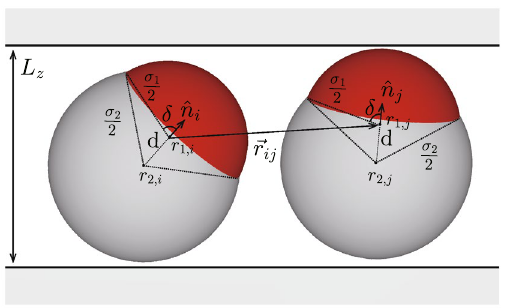
Figure 1. System used in simulations, where dumbbell-like one-patch particles are confined between two flat walls. The particles are synthesized by merging two spheres. Red and white regions represent attractive area and 2 d /(σ 1 σ 2 /σ 1 and l σ 2 ) , non-attractive area, respectively. The shape of particles is characterized by q = = + where σ 2 and σ 1 denote the diameters of the non-attractive and attractive spheres, respectively, d the distance between the centers of the two spheres, and l the dimensionless distance scaled by average diameter. δ satisfies 2 l /( 1 cos δ 4 d 2 )/ 4 d σ 1 ( 1 (σ 2 2 σ 2 1 q ) q ) l 2 . The particle shape is more dumbbell-like with = − − + = − − increasing d . The unit vector directed from the center of the non-attractive sphere to that of the attractive sphere is denoted as ˆ n . σ 1 is set to unit, and the x - and y -directions are set parallel to the walls, and the z -direction is 0 and z L z . With the distance between the two walls set perpendicular to the walls, which are given by z = = √ vN /(ρ L z ) , L y denoted by L z , the lengths of the wall in the x - and y -directions, L x and L y , are given by L x = = where v , ρ , and N denote the volume of the dumbbell-like particle, the particle density, and the number of particles, respectively. The distance between the two walls L z is set to 1.1 [ (σ 1 + σ 2 )/ 2 + d ] . Because L z is slightly longer than the long axis in the dumbbell-like patchy particles, the particles rotate